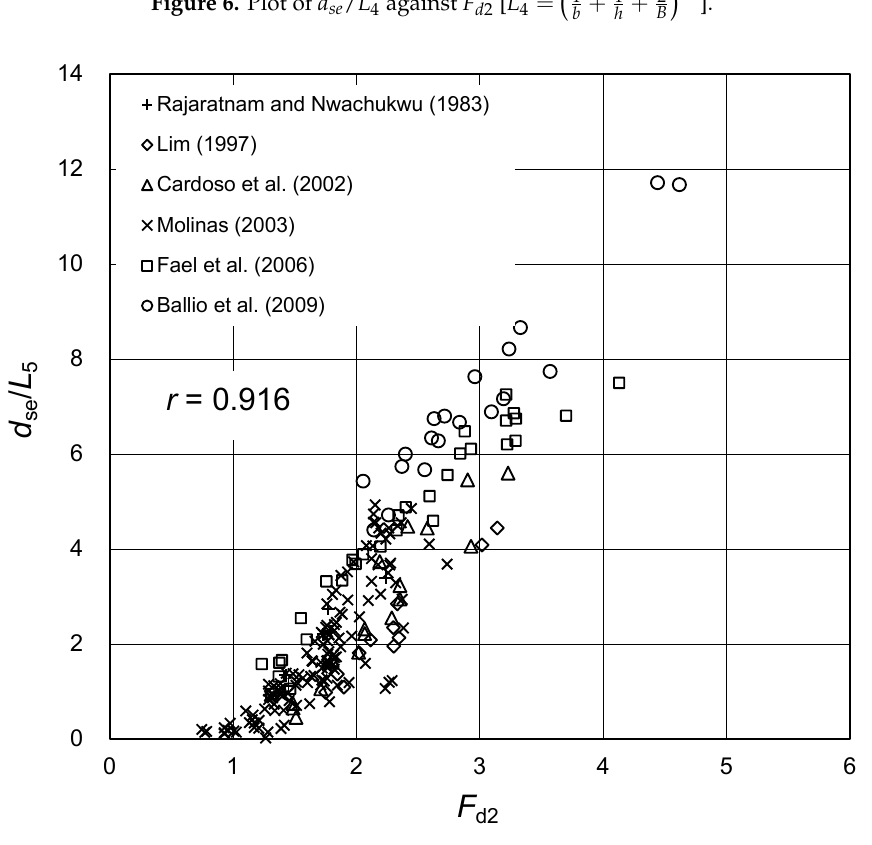
Figure 6. Plot of d se / L 4 against F d 2 [ L 4 =